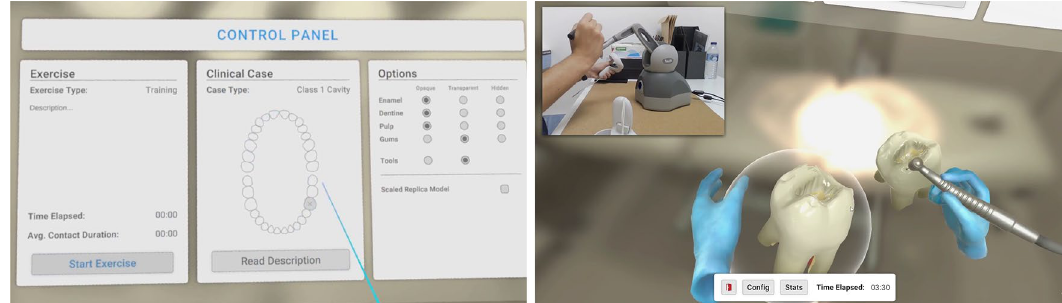
Figure 4. Optional settings: in training mode, the user is given a wide range of settings and information to complement the exercise. A text, visual and spoken description of the clinical case, metrics along with visibility options. The user may start the exercise whenever they are ready to begin. Scaled Replica model: optionally, the user can manipulate a large copy of the tooth in their non-dominant hand for referencing during the